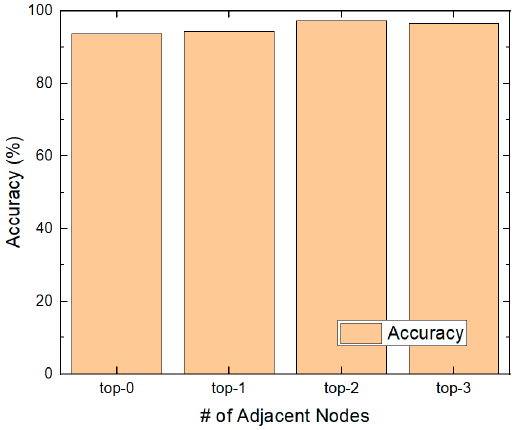
Figure 8. False Positive Rate according to the number of adjacent nodes.